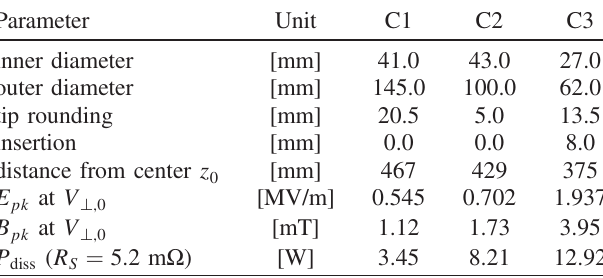
TABLE VI. Properties of fundamental mode couplers.